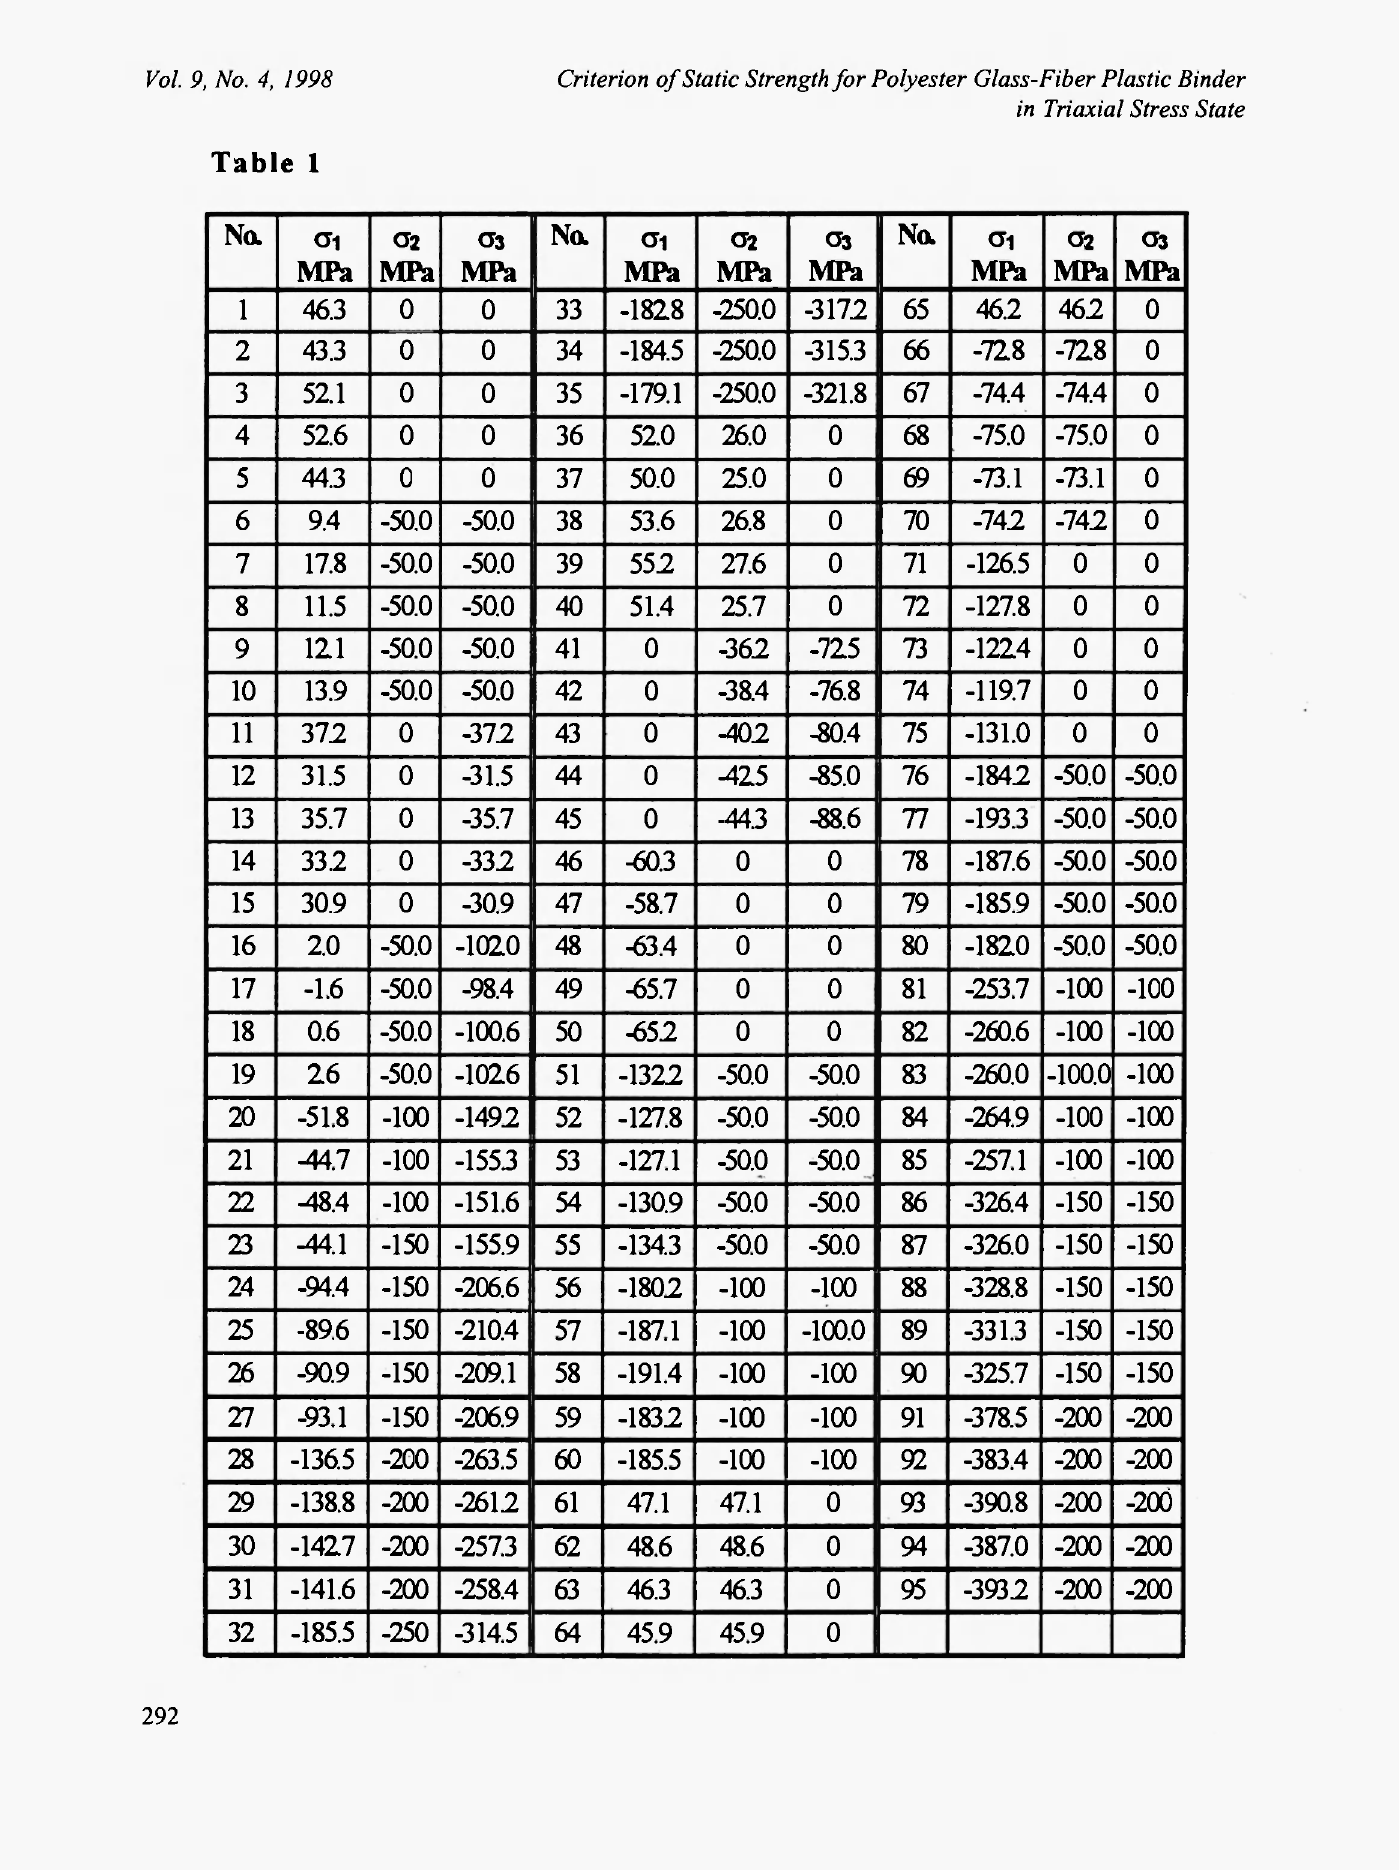
in Triaxial Stress